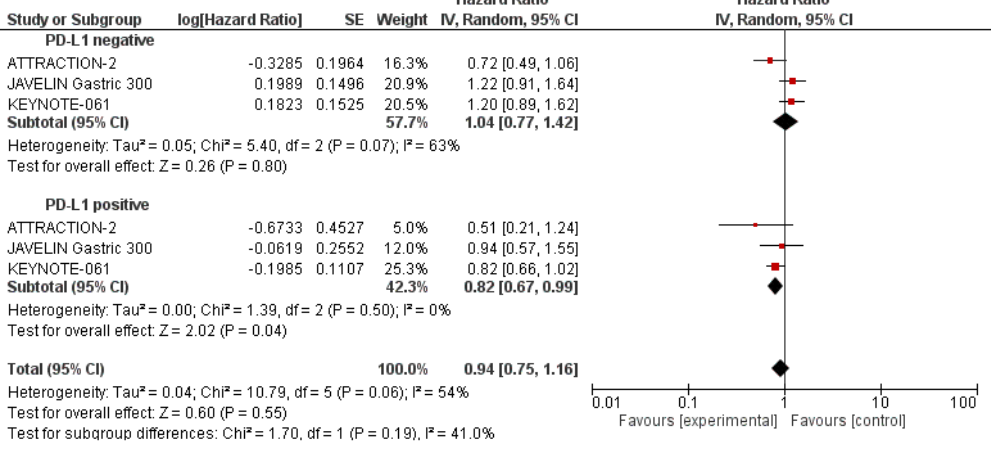
Figure 2. Subgroup analysis for overall survival of immune checkpoint inhibitors compared to the control arm in PD-L1-positive and PD-L1-negative patients. Table 2. Data on overall survival, progression-free survival and tumour response of the included studies.